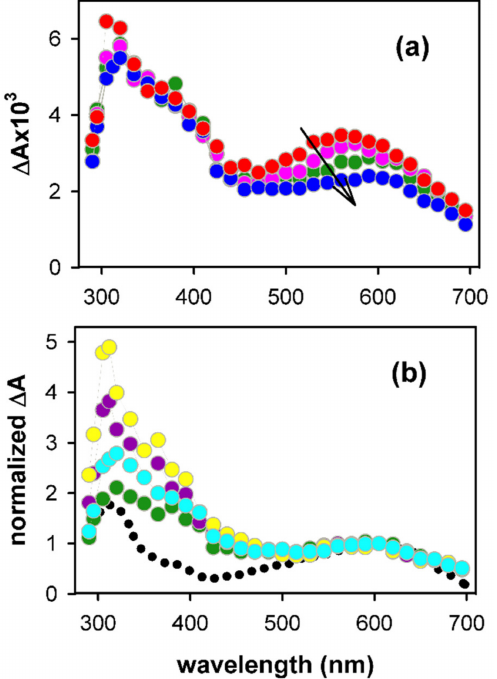
Figure 5. Transient absorption spectra determined for aerated solutions of (AG 4 A) 4 /K + at pH 7 (circles) at 3 µ s (red), 50 µ s (pink), 0.2 ms (green), 0.5 ms (blue), 2 ms (cyan), 6 ms (dark red) and 10 ms (yellow). In ( a ), the experimentally measured ∆ A is shown while in ( b ), ∆ A at 605 nm has been normalized to 1; black dots correspond to the (G-H2) • spectrum reported for monomeric guanosine